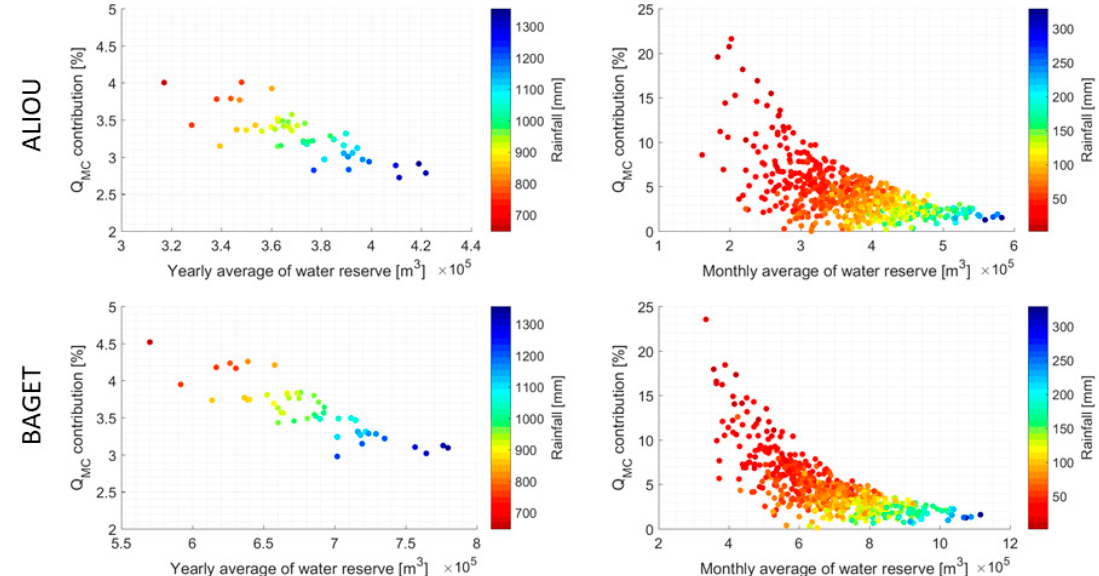
Figure 6. Contribution of the exchange between reservoir M and reservoir C to the total discharge on the annual scale ( left ) and the monthly scale ( right ).